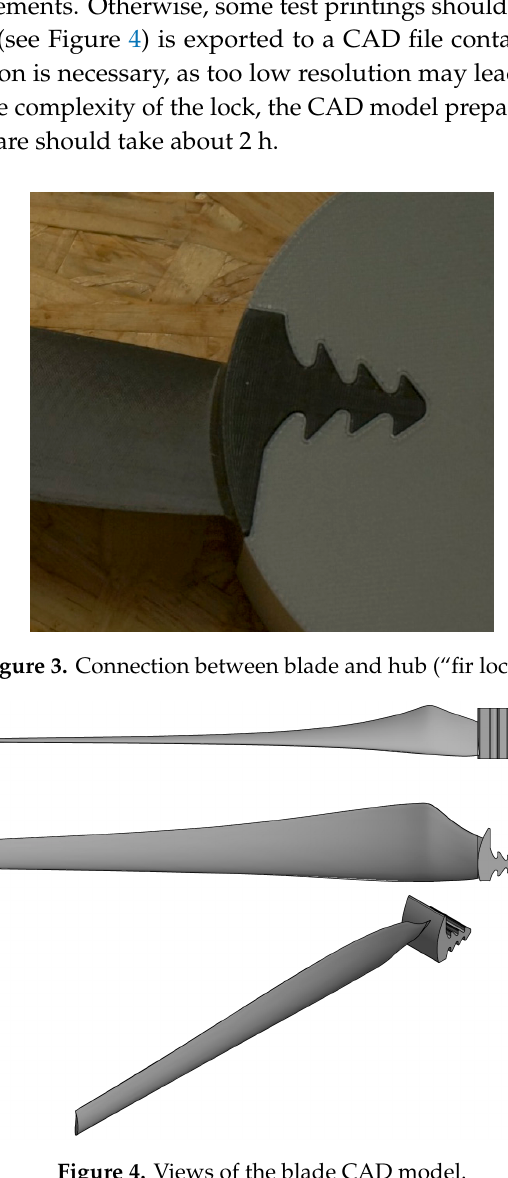
Figure 4. Views of the blade CAD model.